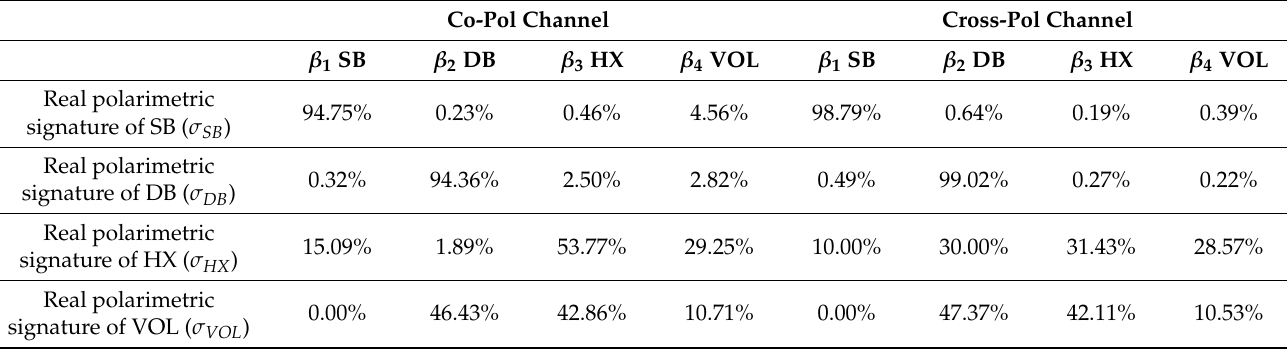
Table 9. Results of SA-based decomposition for real data (co- and cross-polarized channels). Recog- nized signatures are specified in